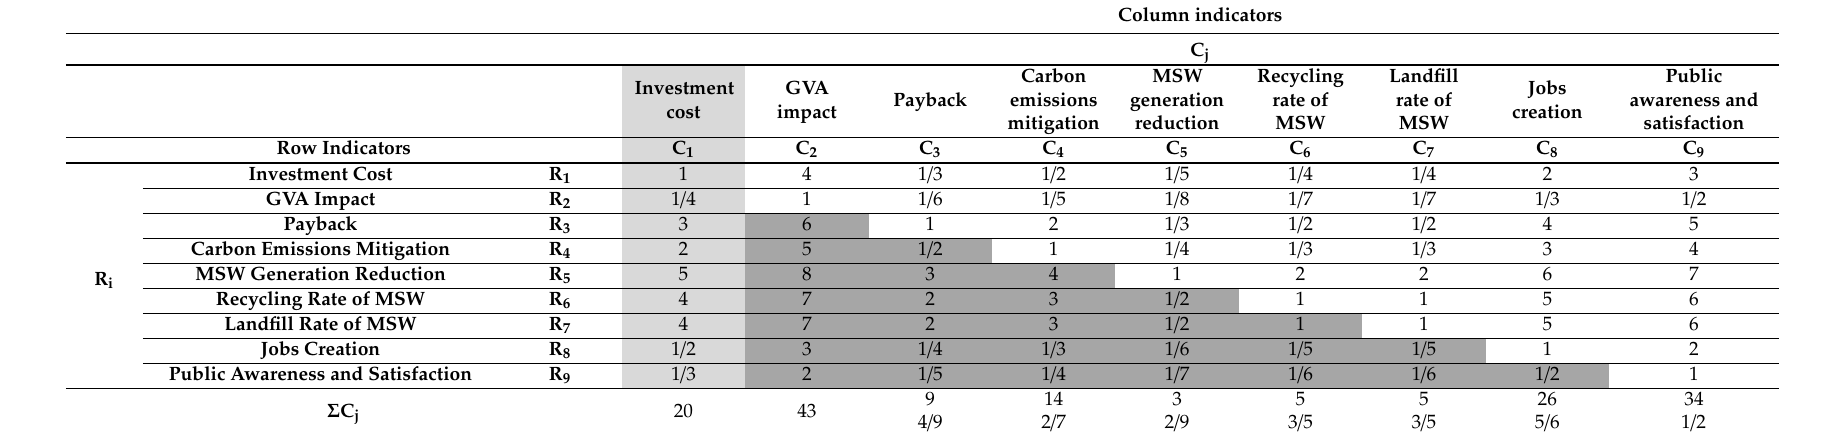
Table 4. Example matrix of pairwise comparisons for stakeholder